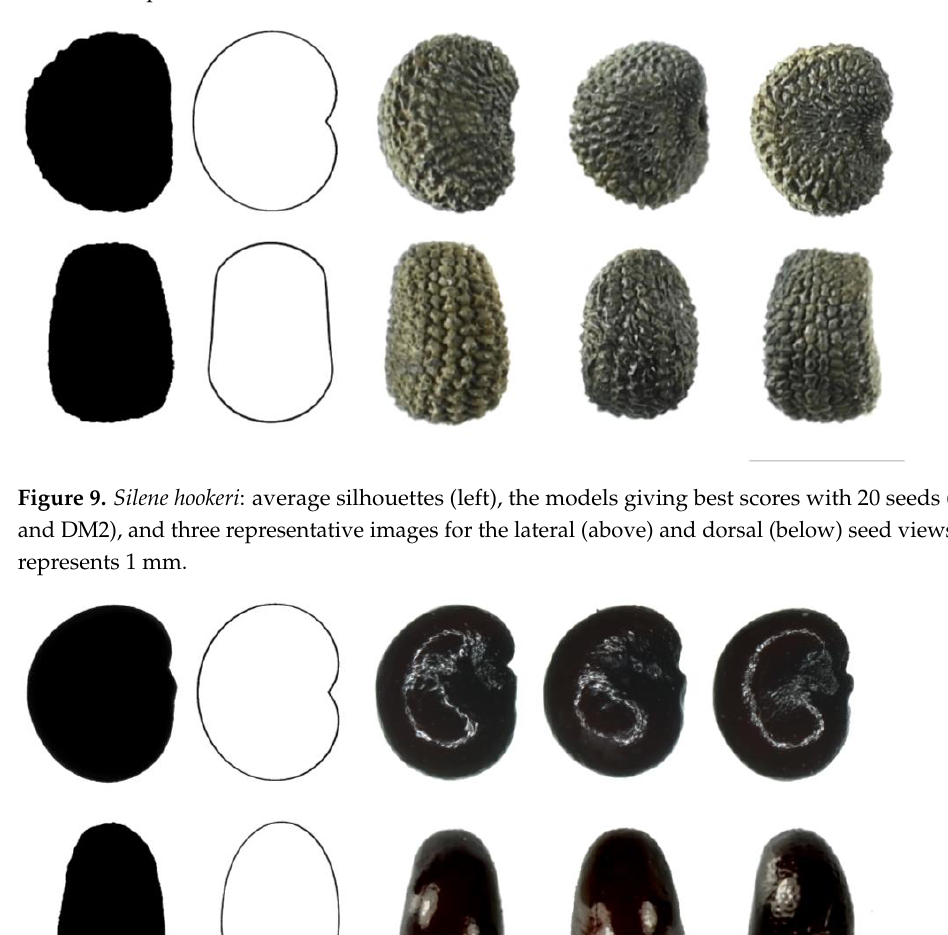
Figure 8. Silene jeniseensis : average silhouettes (left), the models giving best scores with 20 seeds (LM4 and DM1), and three representative images for the lateral (above) and dorsal (below) seed views. Bar represents 1 mm.